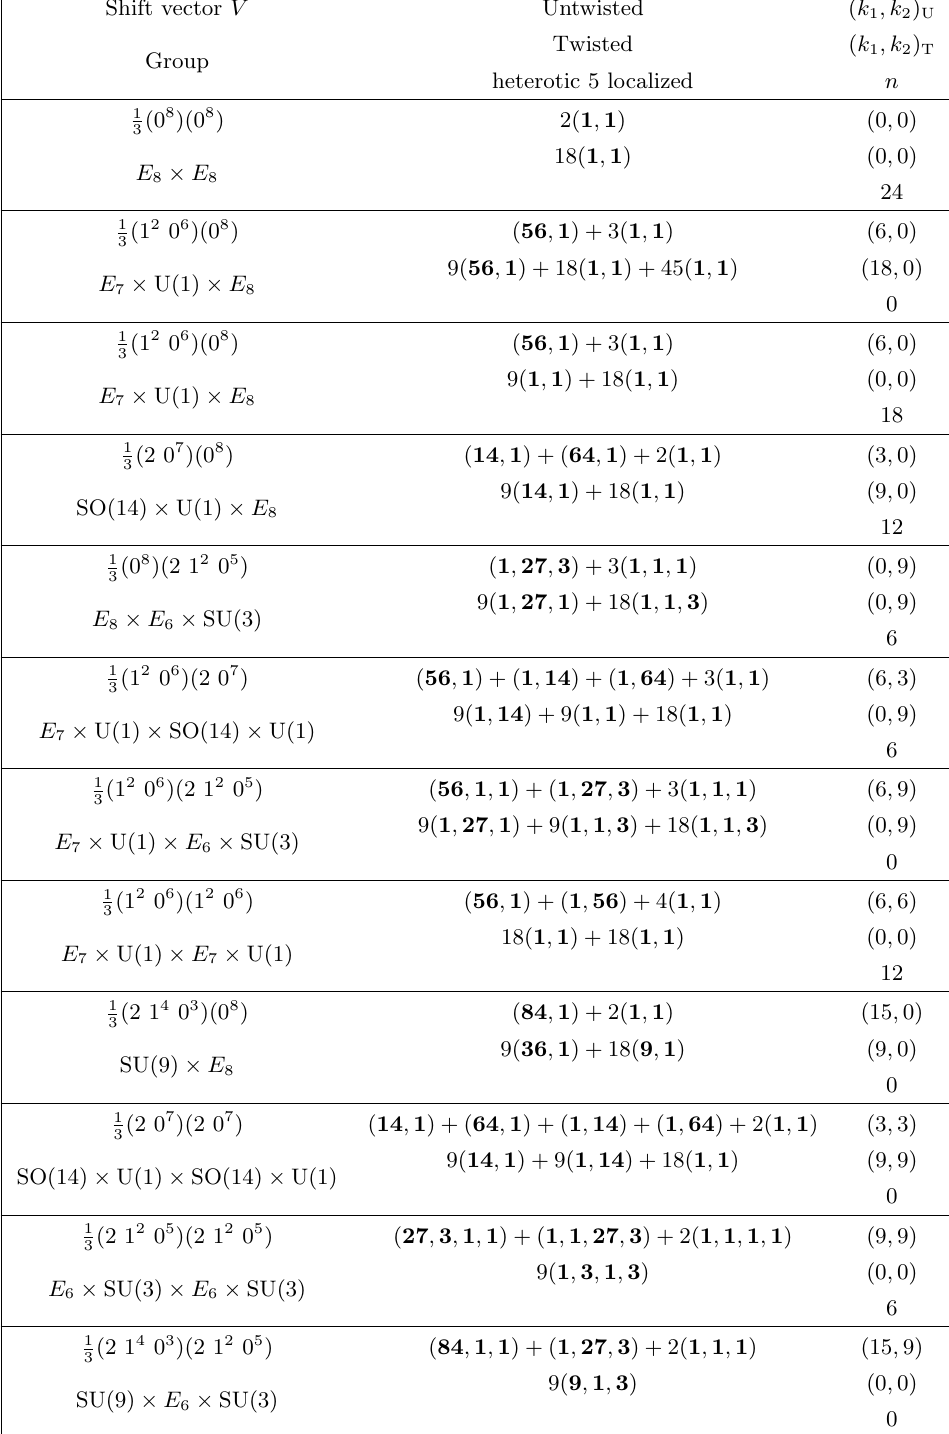
Table 2 . Perturbative ( n = 0) and non-perturbative ( n 6 = 0) vacua of E 8 (cid:2) E 8 heterotic string on T 4 = Z 3